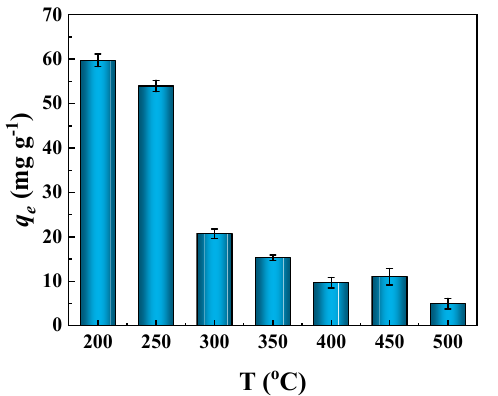
Figure 6. Adsorption of MB by various BCs (CPP200, CPP250, CPP300, CPP350, CPP400, CPP450 and CPP500; MB concentration of 50 mg/L, pH = 7.32, adsorbent dosage of 5.0 mg and contact time of 90 min, T = 25 °C).